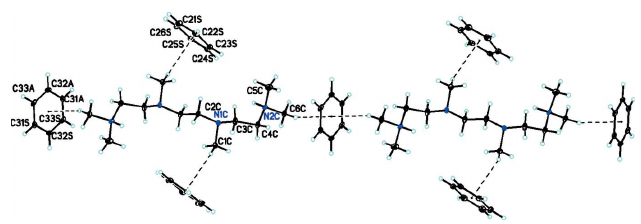
Figure 4 Diagram showing how the C—H (cid:2)(cid:2)(cid:2) (cid:2) interactions between the third benzene solvate molecule and cation C .